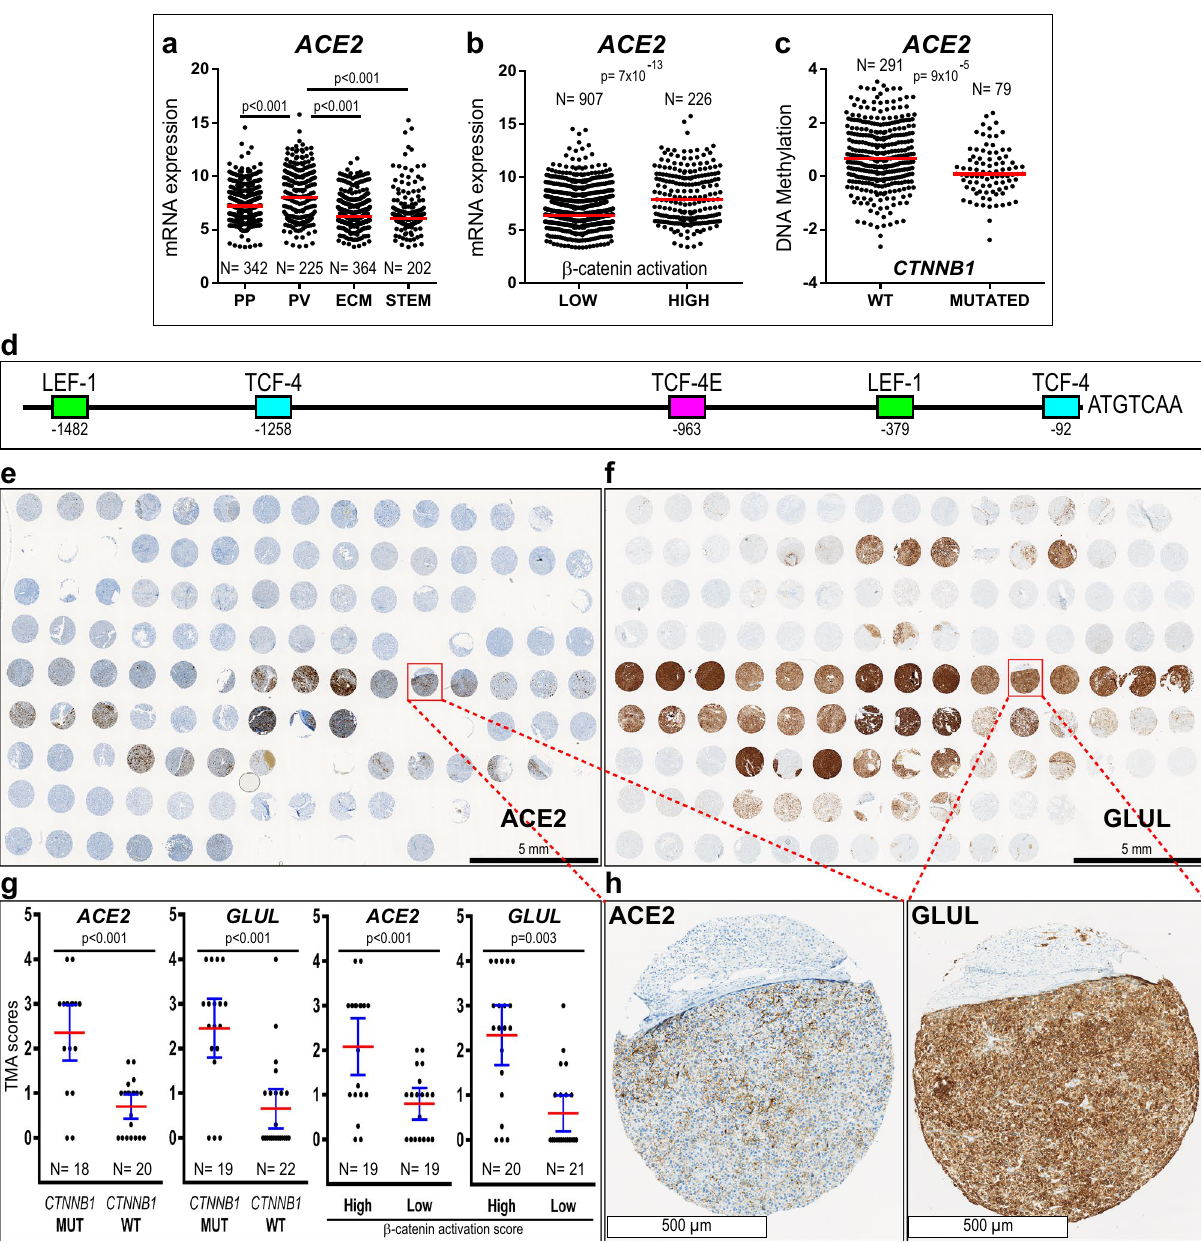
Figure 1. High ACE2 levels in well-differentiated, non-proliferative HCCs, with mutated β-catenin ( CTNNB1 ) and hypomethylated DNA. ( a ) and ( b ) ACE2 mRNA expression in the Désert’s meta-dataset of 1133 HCCs 26 . ( a ) HCC subclasses: PP, periportal-type; PV, perivenous-type; ECM, extracellular-matrix-type and STEM, stem-cell-type HCCs. ( b ) ACE2 mRNA expression according to β-catenin activation levels, assessed as described 26 . ( c ) ACE2 DNA is hypomethylated in HCCs carrying mutated CTNNB1 (TCGA dataset). ( d ) TCF/LEF-1 binding sites, responding to β-catenin transcriptional activation in the proximal ACE2 DNA sequence upstream the transcription start site, according to the PROMO program (TRANSFAC database). ( e ) and ( f ) Immunohistochemical detection ( brown signal ) of ACE2 ( e ) and GLUL (glutamine synthetase, ( f ) in an HCC tissue microarray ( TMA ). Slides were slightly counterstained with hematoxylin ( blue ). Three 1-mm in diameter spots were punched from each formalin-fixed paraffin-embedded routine liver tissue block ( n = 41 HCCs; 2 normal liver controls). Digital slides were acquired with a 20X objective. ( g ) ACE2 and GLUL immunohistochemical signal scoring in HCCs, according to the tumor’s CTNNB1 mutational status, ( MUT ) versus wild-type ( WT ); and β-catenin activation scores, ( High ) versus ( Low ), using the median value as a cut-off ( High, β-catenin activation score > 4). TMA scores are shown as mean (red bar) ± 95% confidence intervals (blue bars). Each dot corresponds to the average out of triplicate tissue cores from each HCC. Statistical differences between means calculated with Mann–Whitney U test. Tumor numbers for each group are indicated. Only were scored those HCCs for which at least two spots were exploitable. TMA 33 and β-catenin activation 26 scoring were performed as we previously described. Average GLUL and ACE2 scores, CTNNB1 mutational status and β-catenin activation scores for each HCC are provided in Supplementary Table 5. (h) Higher magnification from the indicated spots in ( e ) and ( f )